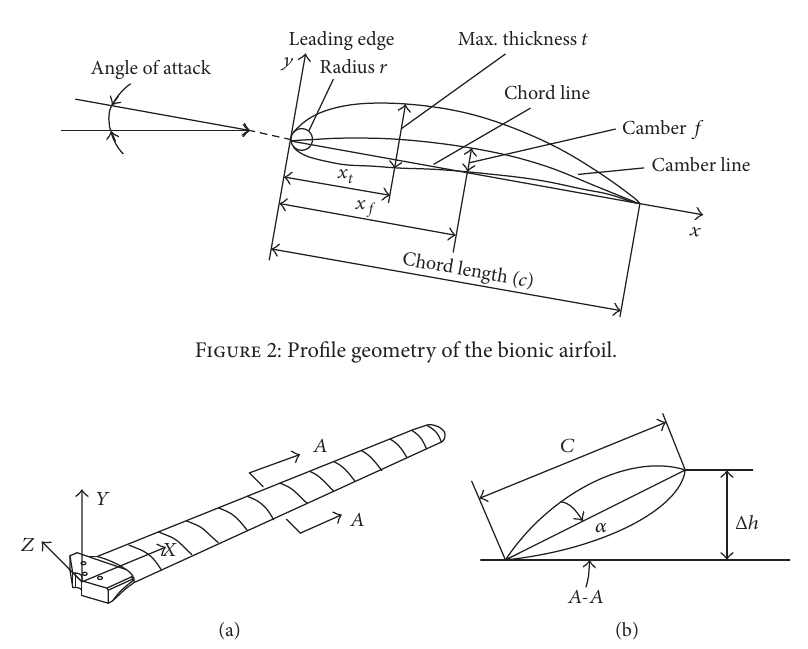
Figure 3: Divisional schematic (a) of a wind turbine blade and the 𝐴 - 𝐴 cross-sectional profile (b).